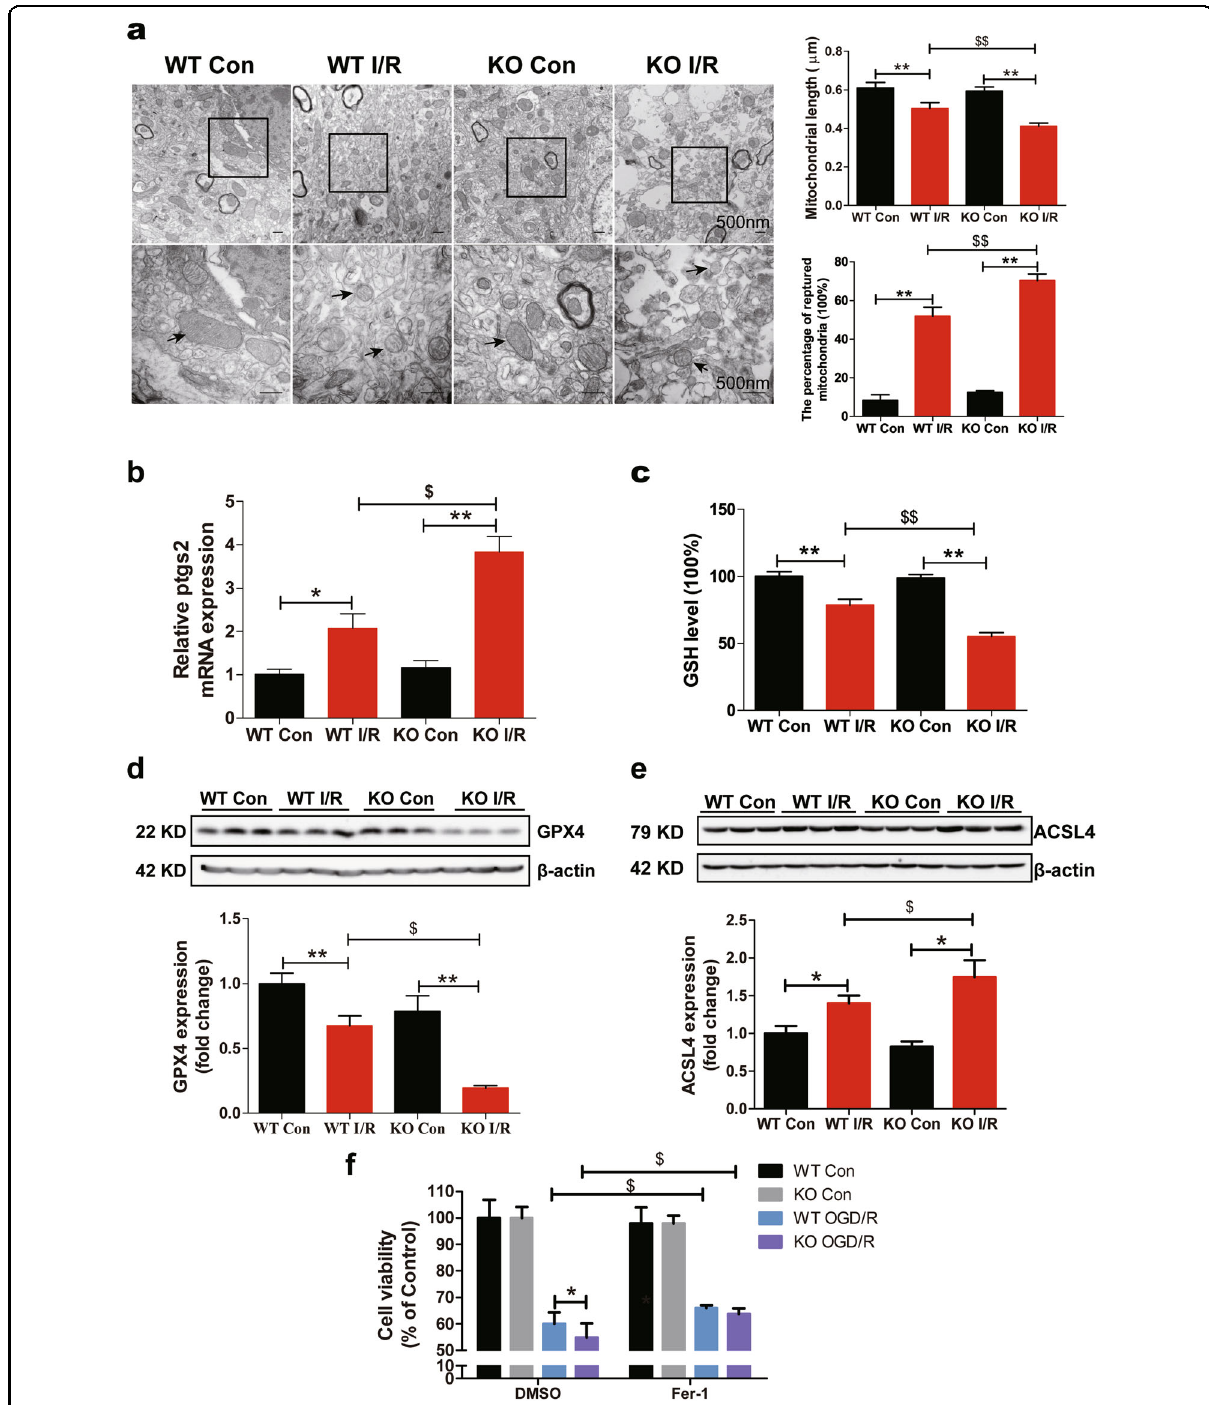
Fig. 3 FtMt deletion aggravates cerebral I/R-induced ferroptosis. Wild-type (WT) and Ftmt -knockout mice were subjected to MCAO (90 min) and subsequent reperfusion (24 h). a Transmission electron microscopy of cells in the control (Con) and I/R groups. Mitochondrial length and the percentage of ruptured mitochondria in different groups were measured and averaged ( n = 3). b The relative mRNA expression of Ptgs2 was measured in Con and I/R tissues. The mRNA levels were normalized to β -actin mRNA levels and are expressed relative to the mean value in the WT Con group ( n = 6). c The GSH content was measured in mice. The data are expressed relative to the mean value in the WT Con group ( n = 5). Western blot analysis of ( d ) GPX4 and ( e ) ACSL4 at 24 h after reperfusion. The data are expressed relative to the mean value in the WT Con group ( n = 5). f Primary neurons were pre-treated with 0.05 μ M Fer-1 for 4 h and then subjected to OGD/R. Cell viability was measured using an MTT assay ( n = 6). The results are presented as the mean ± SEM. * /$ P < 0.05, ** /$$ P <